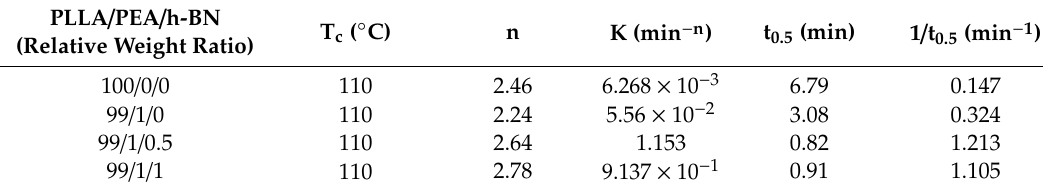
Table 1. The isothermal crystallization kinetics parameters from Avrami equation.